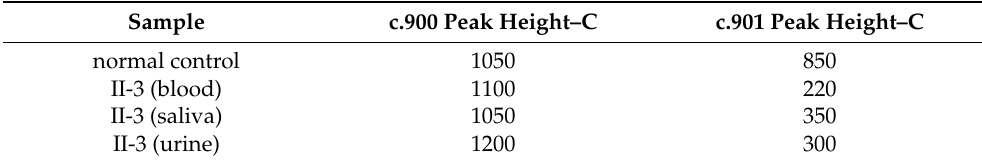
Table 2. Analysis of peak heights for the cytosine (C) nucleotide at positions 900 and 901 demonstrat- ing the lower height of the wild type nucleotide at position 901, consistent with mosaicism. Sample normal control 1050 850 II-3 (blood) 1100 220 II-3 (saliva) 1050 350 II-3 (urine) 1200 300 Peak heights at position c.900 are comparable between the proband (II-3) and a normal control. Peak heights are expressed in relative fluorescent units as reported by Sequencing Analysis Software (Applied